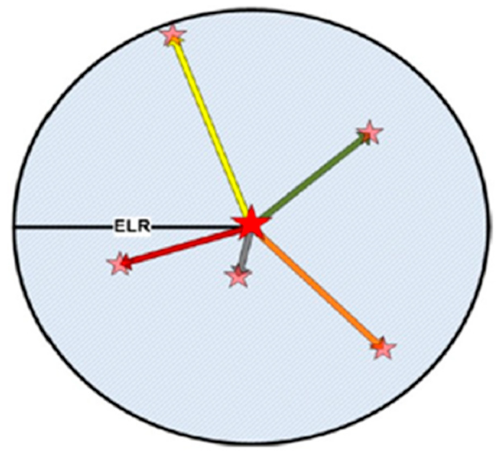
Figure 5. Representation of the cuckoo egg laying radius (ELR).